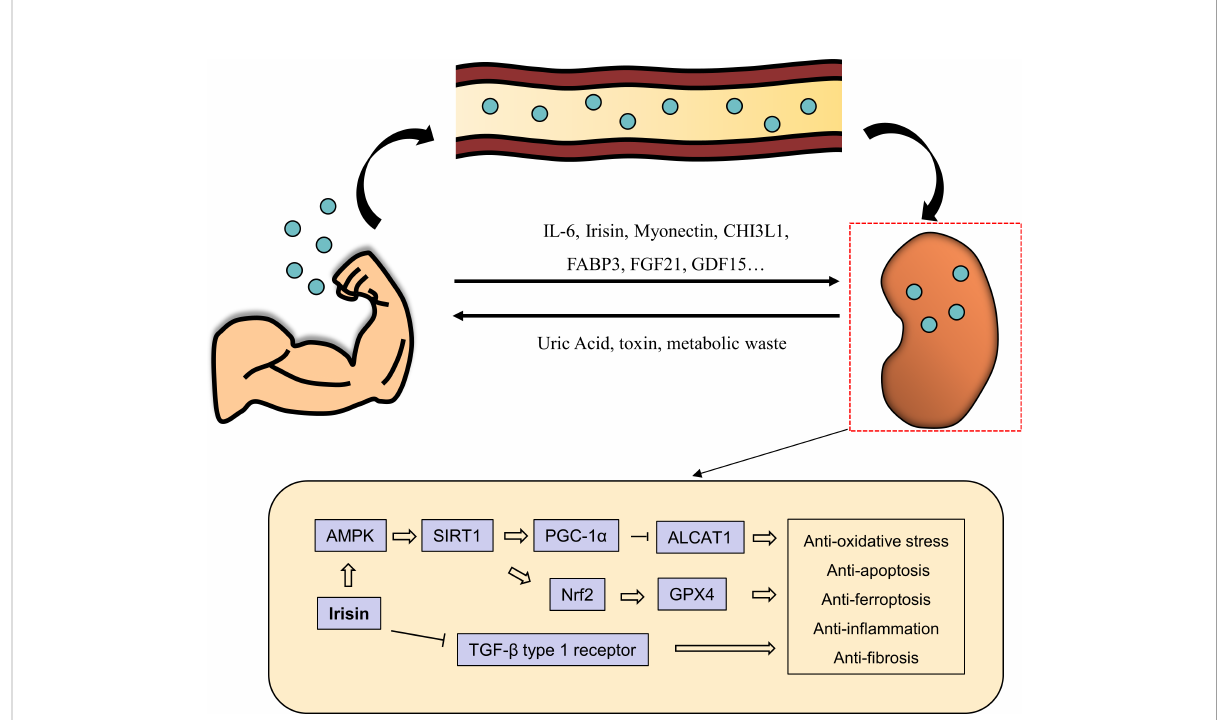
FIGURE 1 The muscle-renal axis. Effective exercise increases the production of myokines, such as IL-6, irisin, myonectin, FABP3, FGF21 and GDF15, from muscles and their secretion into the blood circulation. Myokines then travel through the bloodstream to the kidneys, among other organs, where they